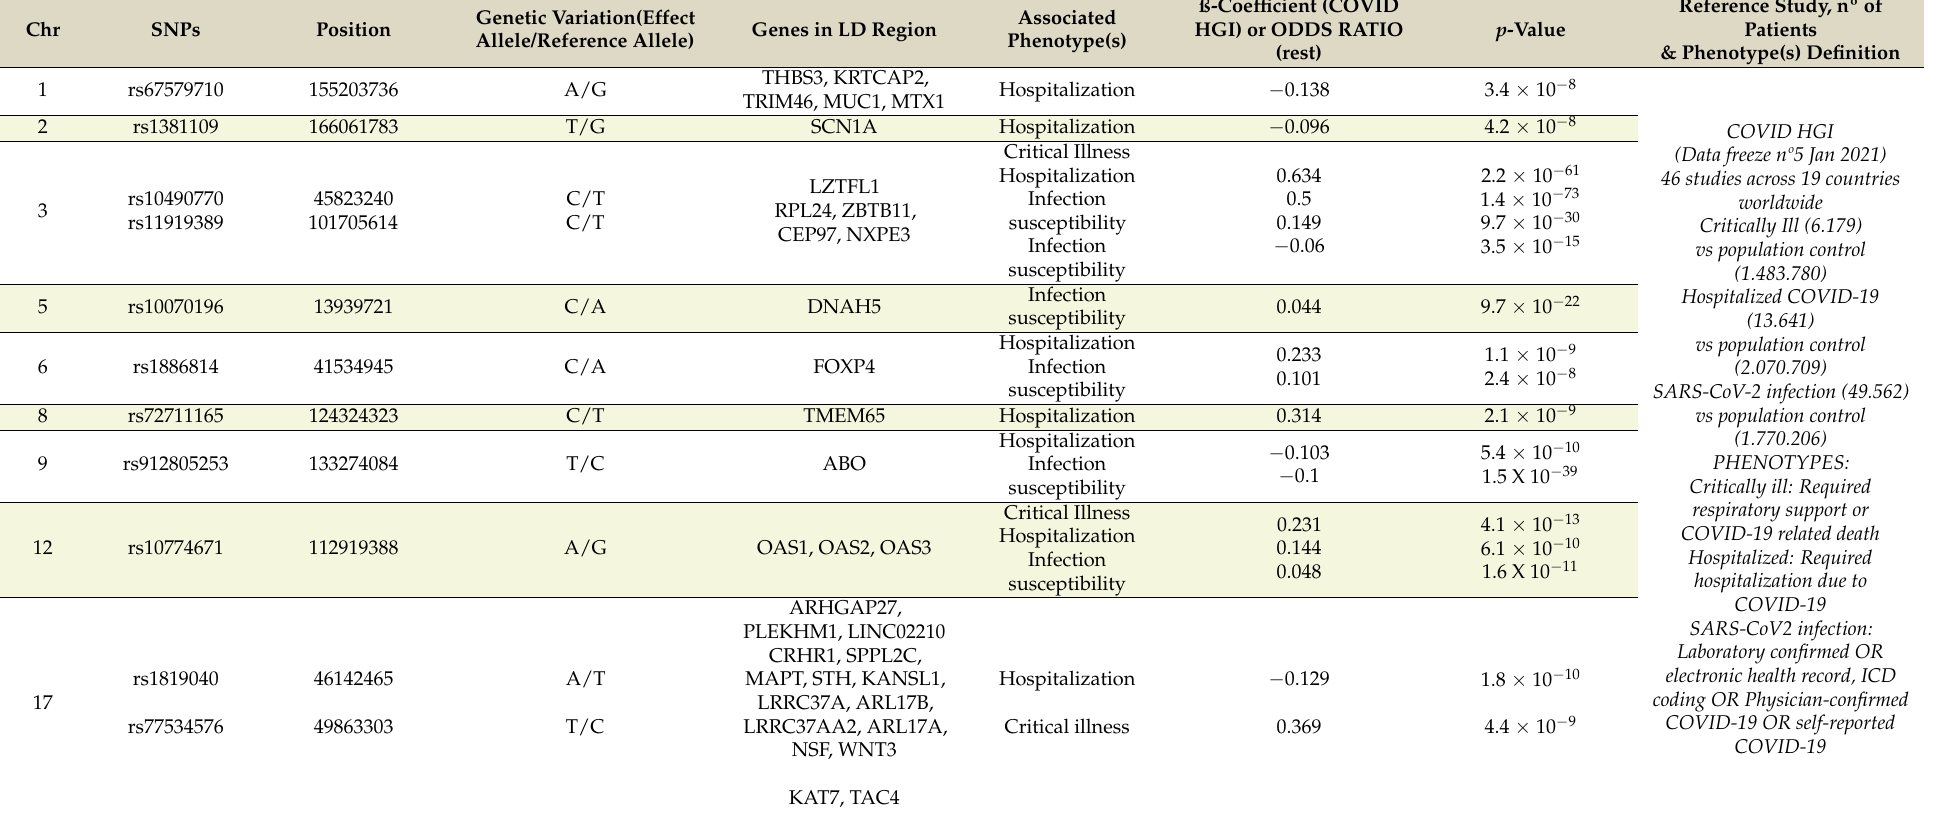
Table 1. List of SNPs significantly associated with COVID-19 risk of infection, hospitalization, or critical illness that have been identified by three of the major genetic studies that have analyzed host genetics. Chr: Chromosome. LD: linkage